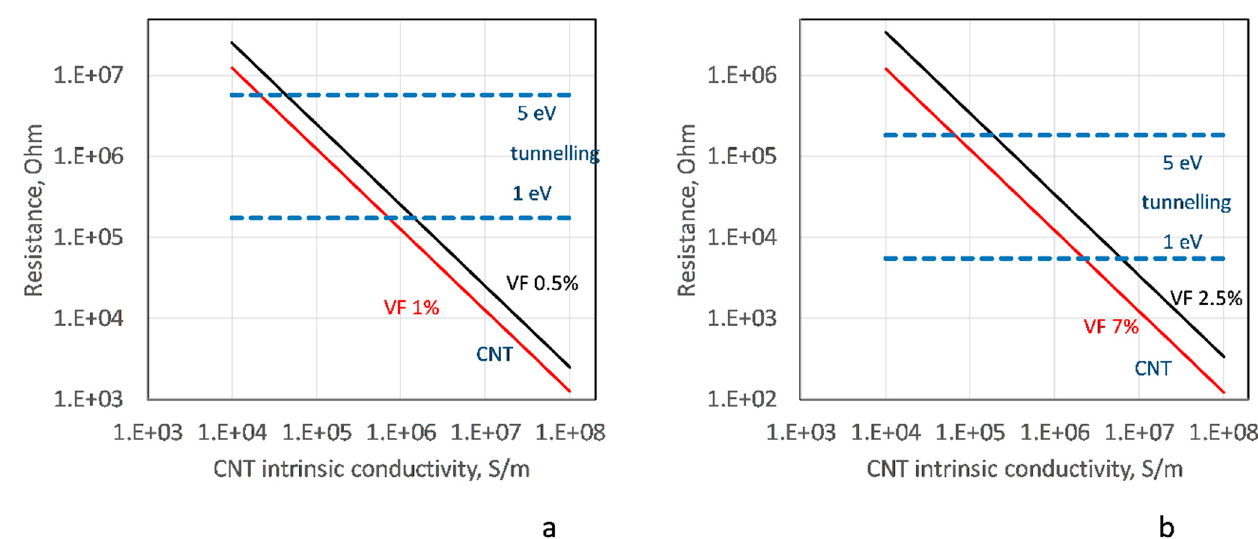
Figure 4. Comparison between the resistance of a typical CNT segment between two contacts for two values of VF (solid lines) and the tunneling resistance in the contact for s = 0.34 nm for two values of ∆ E 1 (dashed lines), R-SW ( a ) and A-MW ( b ).